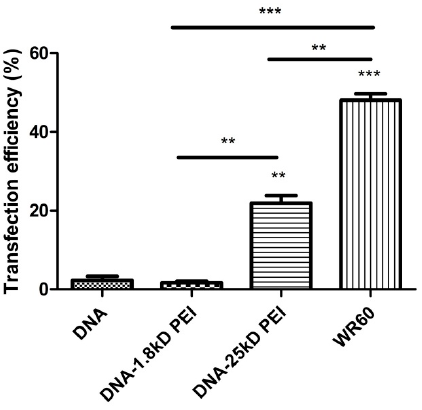
Figure 5. In vitro transfection efficiency of Lovo cells. The WR of PEI-HMSNs to DNA was fixed at 60 and the number of independent determinations was at least three (**, *** p < 0.05). Cellular uptake of nanoparticles was studied by tracking the distribution of fluorescent DNA- PEI-HMSNs. Fluorescein isothiocyanate (FITC) is an electrophile and it normally reacts with